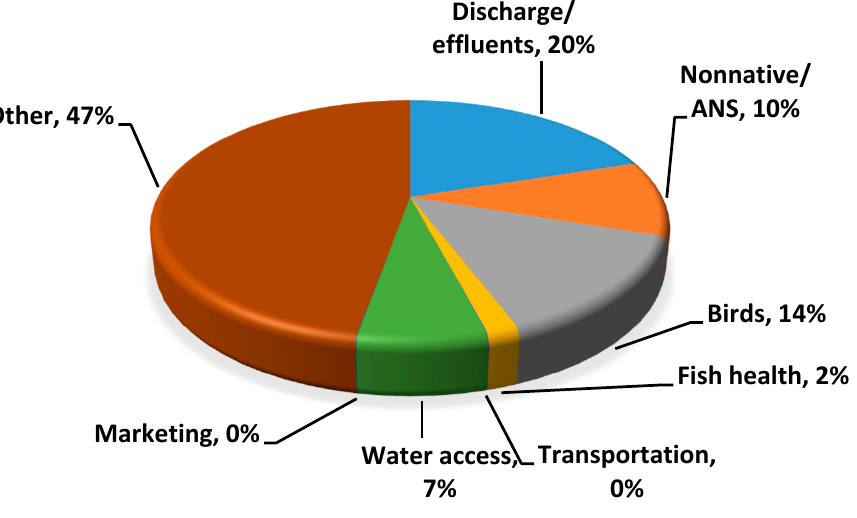
Figure 6. Regulatory cost by type of regulation (% of regulatory cost).